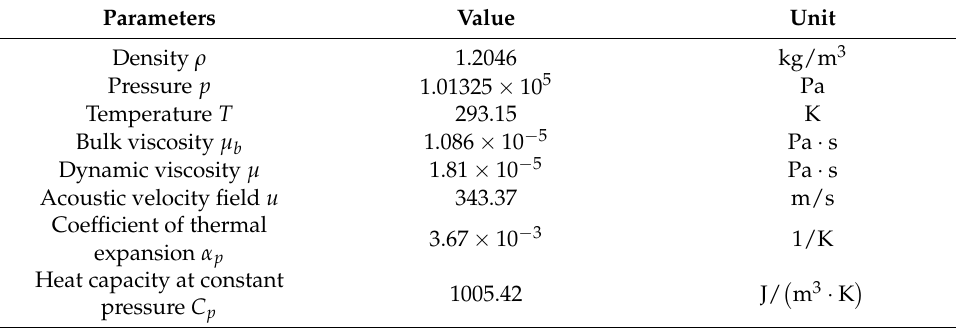
Table 1. The values of the input parameters in the model.